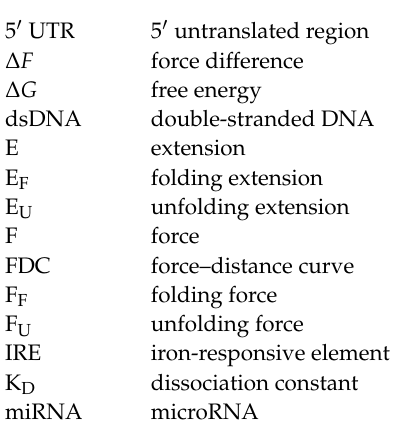
preparation, Figure S1: Force histograms of the WT pre-miRNA-377 in different buffers, Figure S2: Extension histograms of the WT pre-miRNA-377 in different buffers, Figure S3: Unfolding and folding forces, and force difference of the WT pre-miRNA-377 in different buffers, Figure S4: Force and extension histograms of the pre-miRNA-377 loop mutant in the Na + /Mg 2+ buffer, Table S1: Oligonucleotide sequences used in optical tweezers experiments, Table S2: Statistical analysis of the WT pre-miRNA-377 unfolding force ( F U ) in different buffers, Table S3: Statistical analysis of the WT pre-miRNA-377 folding force ( F F ) in different buffers for the three types of folding FDCs, Table S4: Statistical analysis of the WT pre-miRNA-377 force difference ( ∆ F ) in different buffers for the three types of folding FDCs, Table S5: Statistical analysis of the WT pre-miRNA-377 vs. loop mutant unfolding force ( F U ), folding force ( F F ) and force difference ( ∆ F ) in the Na + /Mg 2+ buffer for folding FDCs type